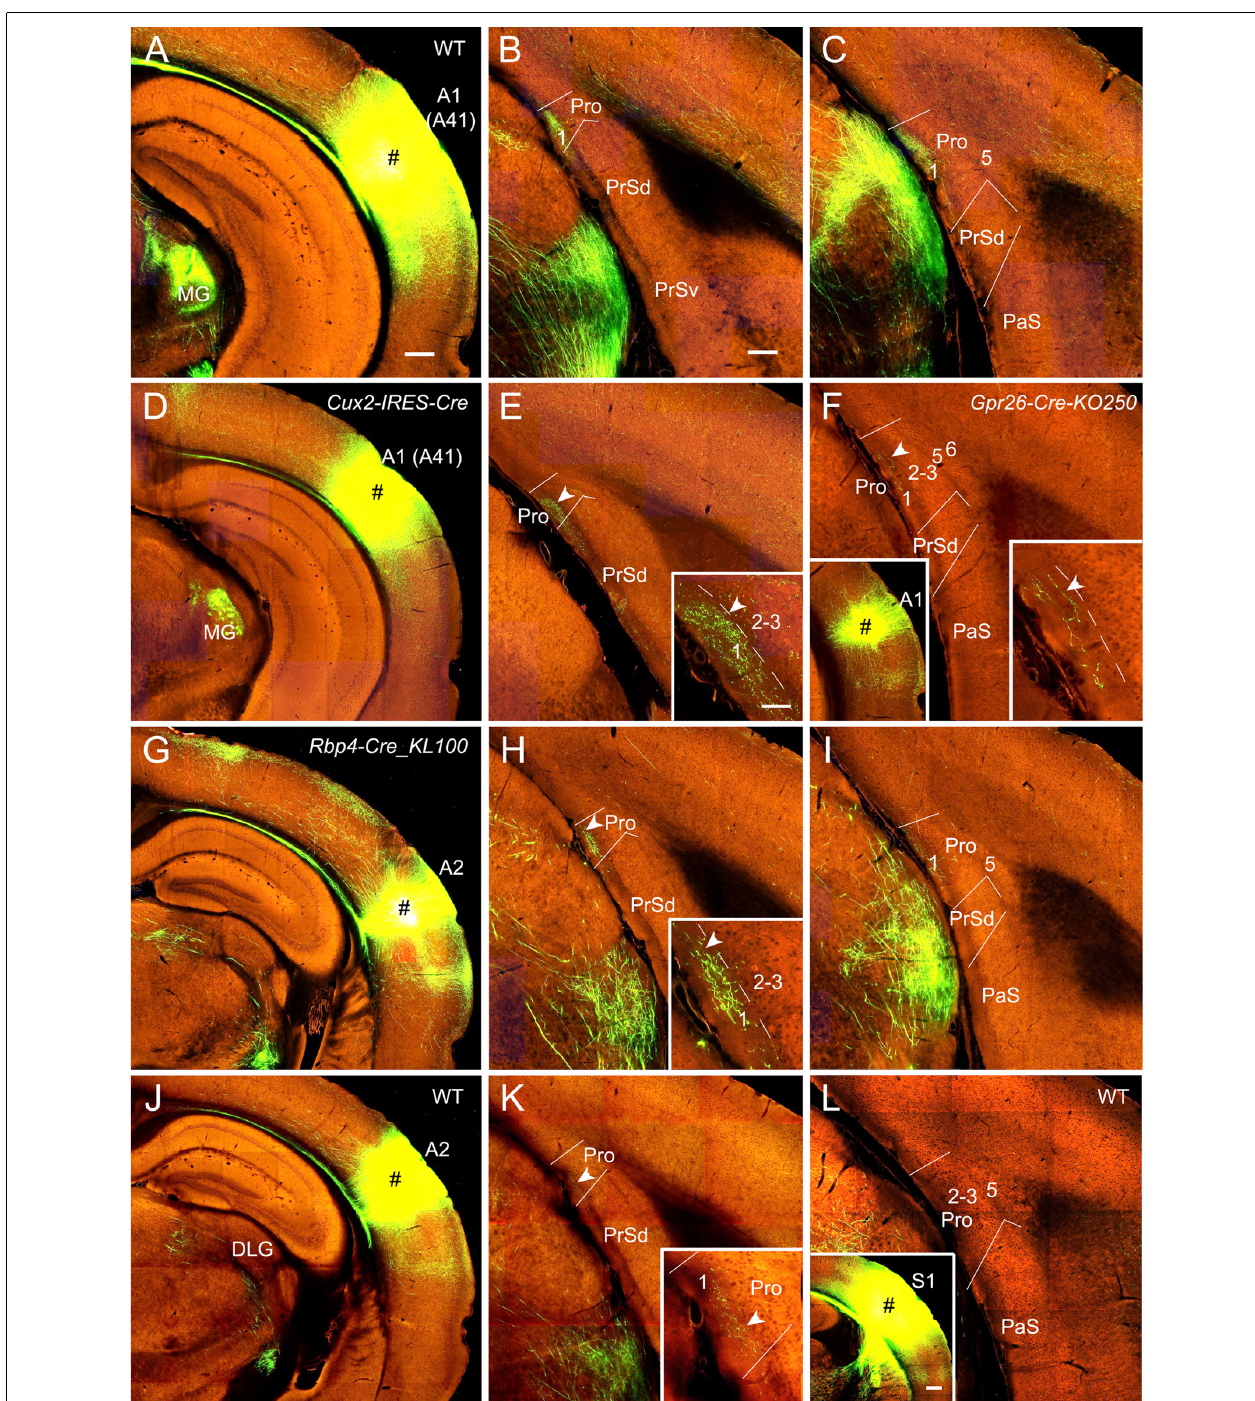
FIGURE 3 | Projections from the auditory cortex to the Pro. For most cases, two coronal sections (one from rostral and the other from caudal levels) of the Pro are shown. (A–C) An injection in A1 (i.e., Brodmann area 41; # in A ) of a WT (wild type) mouse results in strong axon terminal labeling in L1 of the Pro (B,C) . (D,E) An injection in A1 (# in D ) of a Cux2 -IRES-Cre mouse gives rise to moderate terminal labeling in L1 of the Pro (E) with magnified image in the inset. (F) A small injection in A1 (# in the left inset) of a Gpr26 -Cre_KO250 mouse produces weak terminal labeling in L1 of the Pro with magnified image in the right inset. (G–I) An injection in A2 (# in G ) of a Rbp4 -Cre_KL100 mouse yields moderate or weaker terminal labeling in L1 of the Pro (H,I) . The labeling in (H) is magnified in the inset. (J,K) An injection in A2 (# in J ) of a WT mouse leads to weak terminal labeling in L1 of the Pro (K) , which is magnified in the inset. (L) An injection in S1 (# in the inset) of a WT mouse leads to no terminal labeling in the Pro. Arrowheads in low and high magnification images of the Pro point to corresponding locations. Bars: 350 µ m in panel (A) (for A , D , G , J and the left inset in F ); 200 µ m in (B) (for other panels); 350 µ m in the inset in (L) ; and 70 µ m in the inset in (E) (for all other insets).